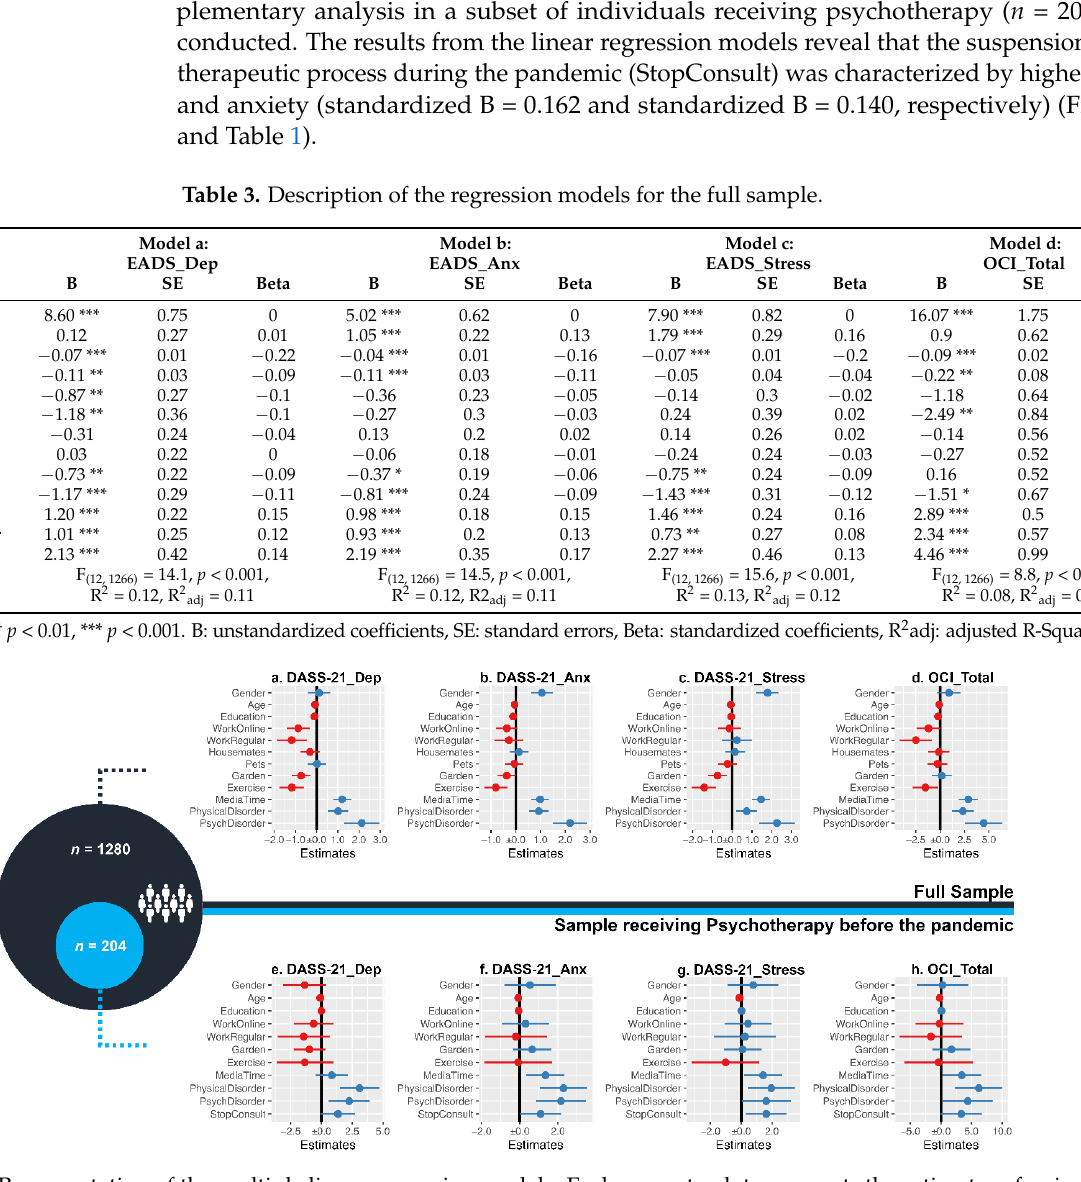
Figure 1. Representation of the multiple linear regression models. Each separate plot represents the estimates of a single linear regression model (the dependent variable Y is specified in the plot title). The vertical line corresponds to the bound-ary of statistical significance (i.e., no effect). Each row represents one predictor X: the dot is the regression coefficient, i.e., the estimated change in the outcome variable Y for each unit increase in the predictor X (blue and red correspond to positive and negative effects); the 95% confidence interval for the coefficient is represented as the segment line—if the interval does not cross the vertical line, X has a statistically significant effect on the dependent variable Y (considering a p -level of 0.05). The top of the figure (a-d plots) includes the regression models for the full sample ( n = 1280); the predictors that were statistically significant in at least one model were included in the regression models for the subsample (f-h plots; n = 204; individuals receiving psychotherapeutic/psychiatric treatment before the pandemic—this sample was extracted from the initial sample of 1280 individuals). DASS-21: Depression, Anxiety and Stress Scale; Dep, Anx and Stress represent the different dimensions of DASS-21; OCI_Total: total score on the Obsessive-Compulsive Inventory—Revised version; Gender: dichotomous variable (0: male respondents); Exercise and MediaTime represent the daily time (1: one hour or more) practicing physical exercise and looking for COVID-19-related information, respectively; WorkOnline, WorkRegular, Garden, Pets and Housemates are dichotomous variables. PhysicalDisorder and PsychDisorder: presence of previous diagnosis of a physical or psychological condition, respectively; StopConsult: indicates whether the individual stopped receiving psychotherapeutic support as a consequence of the